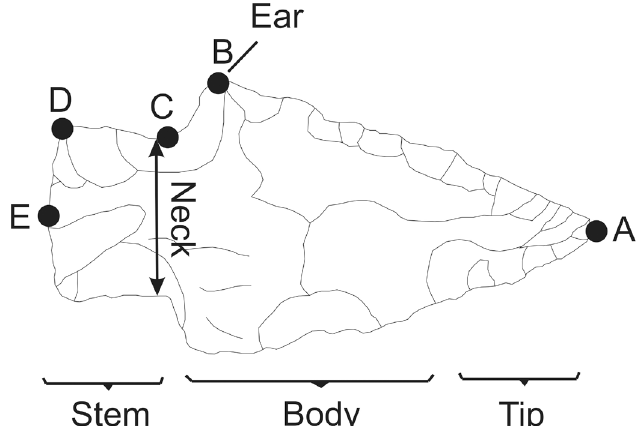
Figure 2: Drawing presenting the different parts of a bifacial point and landmark configuration used to characterize the different parts of a bifacial point. (A) the apex of the body in the longitudinal line (distal end), also defined as the junction of the two blade edges, (B) the most extreme point in the shoulder curve, (C) the point where the neck meets the body, (D) the meeting of the lateral and the basal parts of the stem, and (E) the most extreme point of the stem in the longitudinal